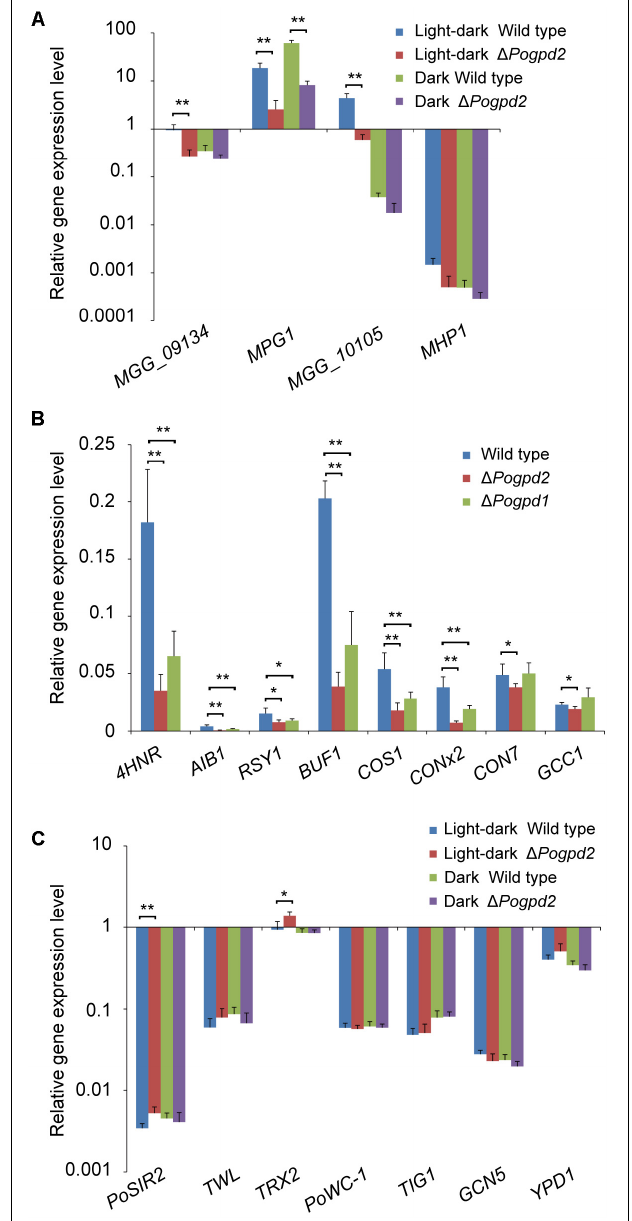
FIGURE 6 | Expression level analysis of genes involved in aerial hyphal differentiation and conidiation in the mutants. (A) Relative expression level of four hydrophobic protein genes ( MGG_09134 , MPG1 , MGG_10105 , and MHP1 ) in the aerial mycelia of (cid:49) Pogpd2 cultured on CM medium under a light–dark cycle or a continuous dark condition. (B) Relative expression level of four melanin synthesis genes ( 4HNR , AIB1 , RSY1 , and BUF1 ) and four conidiation-required transcription factor genes ( COS1 , CONx2 , CON7 , and GCC1 ) in the aerial mycelia of (cid:49) Pogpd1 and (cid:49) Pogpd2 cultured on CM medium under a light–dark cycle. (C) Relative expression level of seven light-sensitive protein genes ( PoWC-1 , TWL , TIG1 , GCN5 , YPD1 , PoSIR2 , and TRX2 ) in the aerial mycelia of (cid:49) Pogpd2 cultured on CM medium under a light–dark cycle and a continuous dark condition. β -TUBULIN and H3 were selected as reference genes. Error bars represent SD. Significant difference compared with the wild type as estimated by Tukey’s HSD test: ∗ P < 0.05 and ∗∗ P <